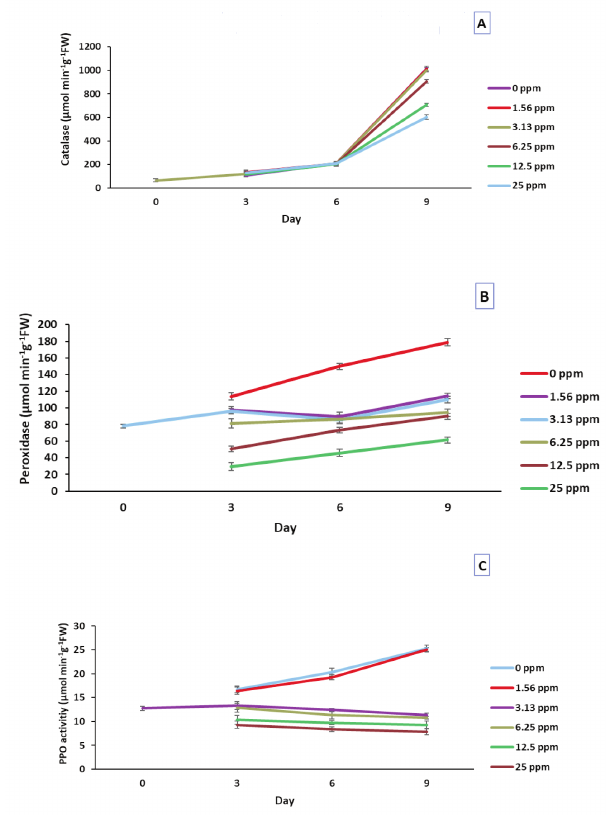
Fig. 4 ­ The influence of cumin EO concentrations on the activity of catalase (A), peroxidase (B), and PPO (C) under diffe­ rent observation periods in cold­stored radishes. Means ± SD of six replicates of two seasons are given (Tukey,